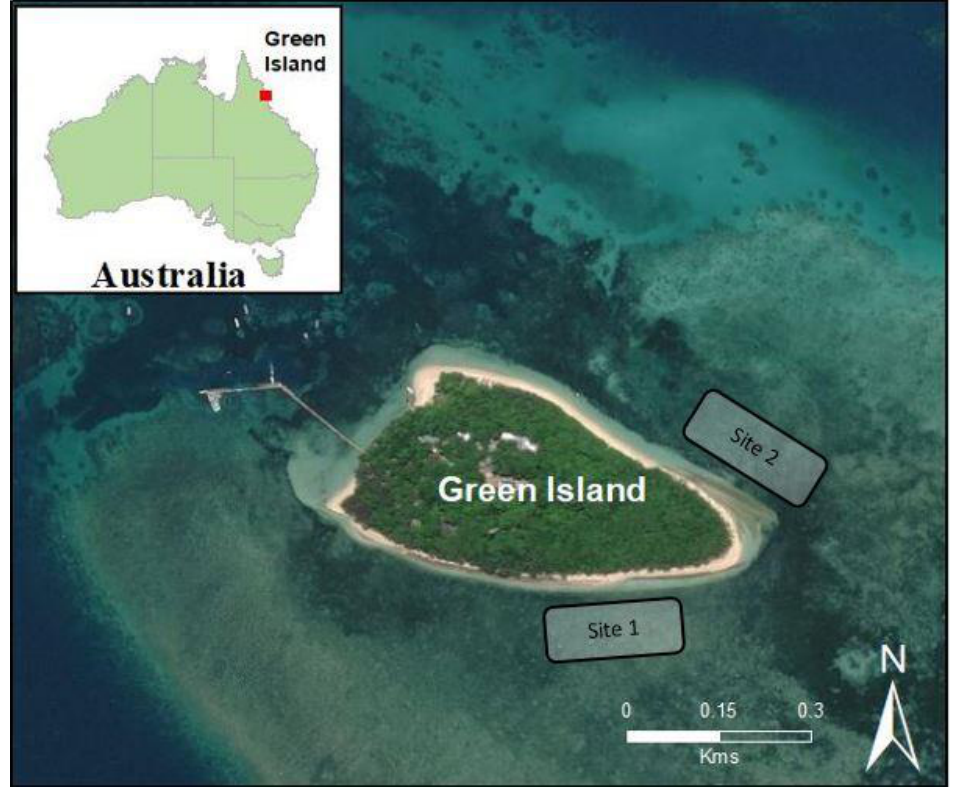
Figure 1. Arial view of Green Island with site deployment, each containing 11 paired control and treatment plots. Service layer credits: Source ESRI, Digital Globe, GeoEye, Earthstar Geographics, CNES/Airbus DS, USDA, USGS, AeroGRID, ING and the GIS User